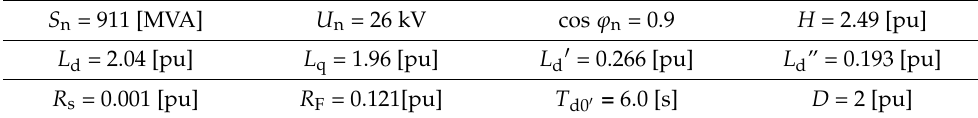
Table A7. Manufacturer’s data: turbo-type synchronous generator S n = 911